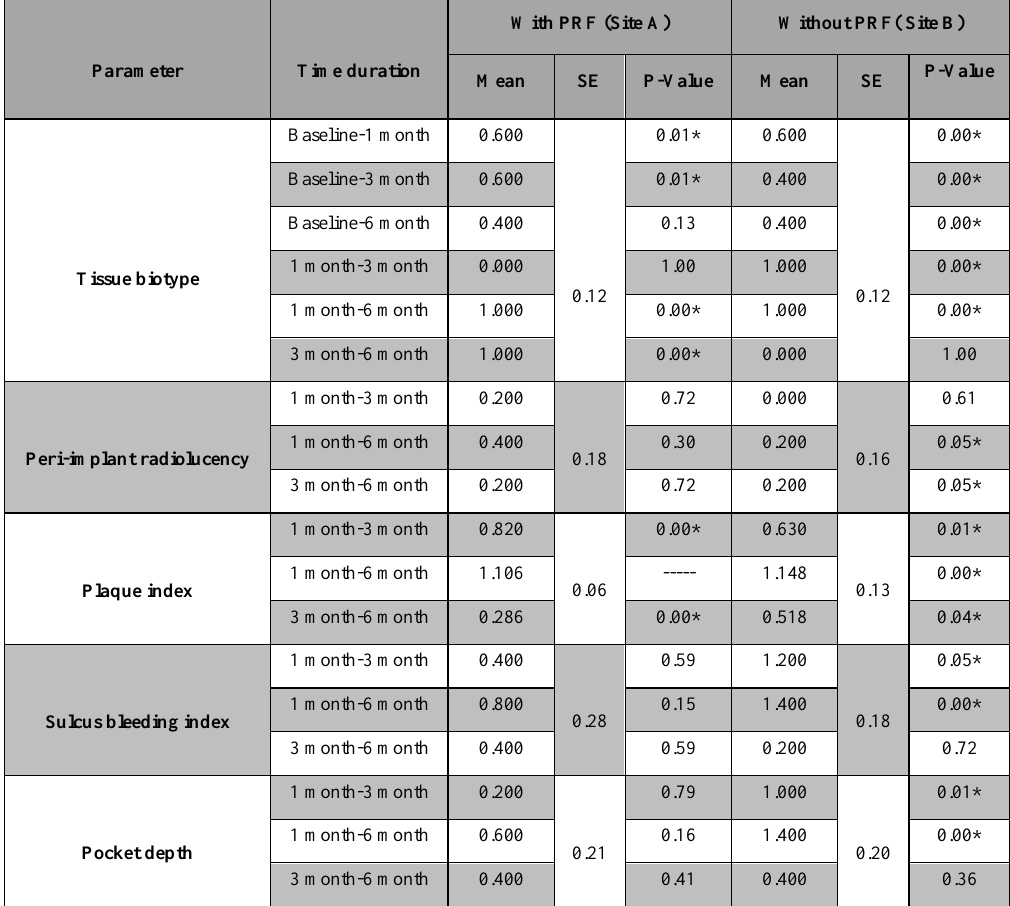
Table 3. Representing the intersite comparison without l-prf and with